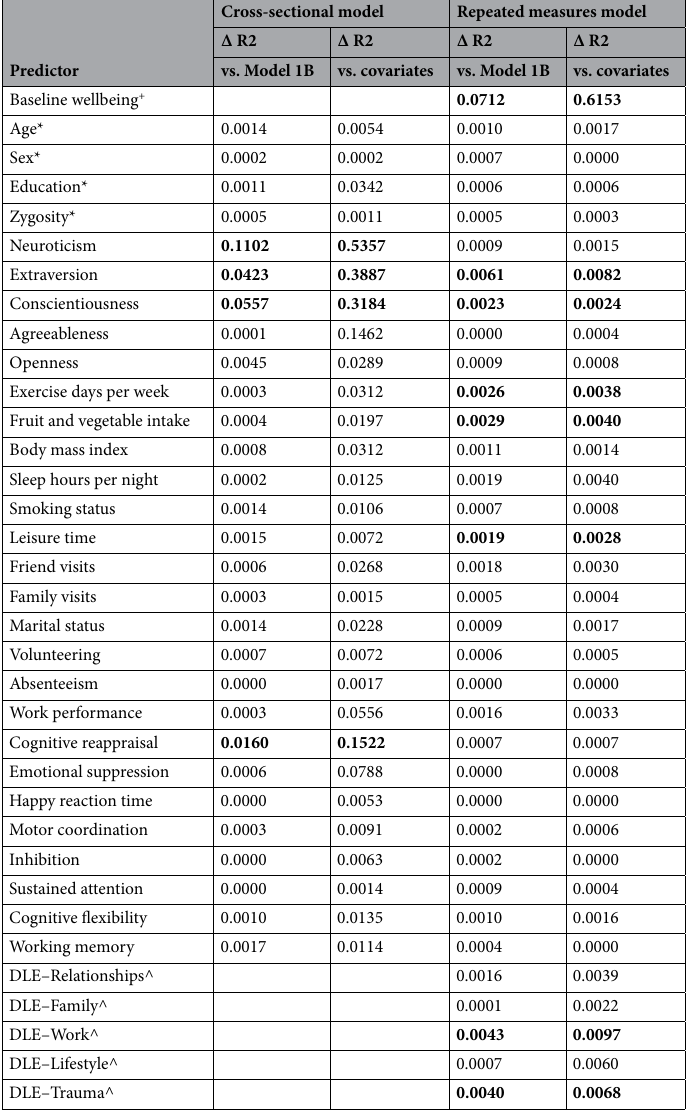
Table 1. Delta R 2 for predictors of baseline wellbeing (cross-sectional model) and follow-up wellbeing (repeated measures model) relative to the selected and covariate-only models. *Variables included as covariates. + Included as covariate in follow-up model only. ^ Daily Life Events refer to events or changes occurring between Time 1 and Time 2 and are thus only included in the repeated measures model. Variables predicting at least at least 0.2% of unique variance in each model are indicated in bold. N =